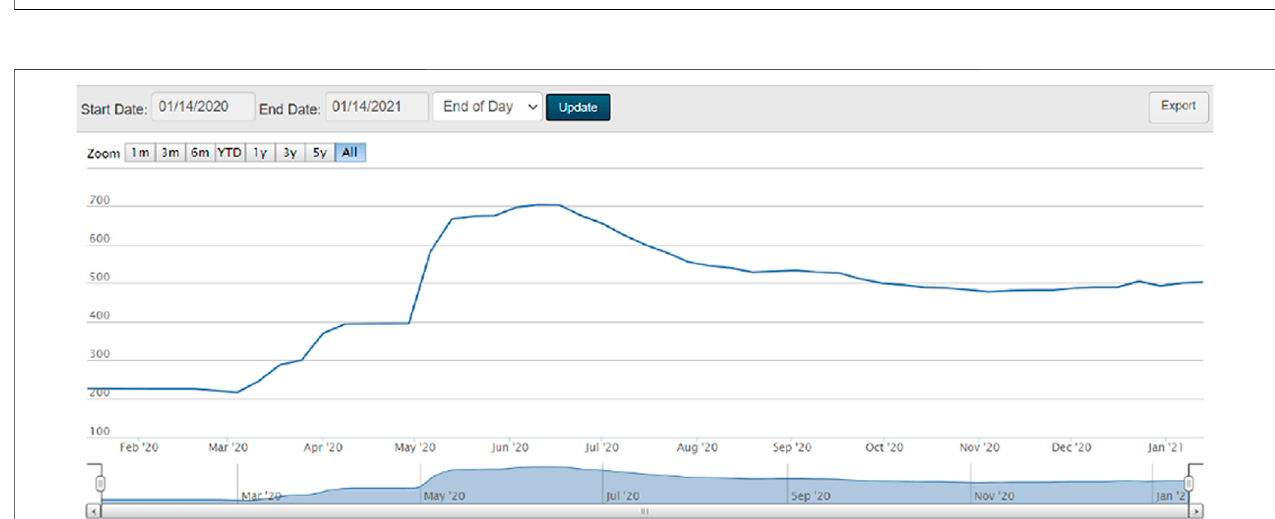
FIGURE 6 | Water per acre/ft, 14 January 2020-14 January 2021. Source: Nasdaq (2020).